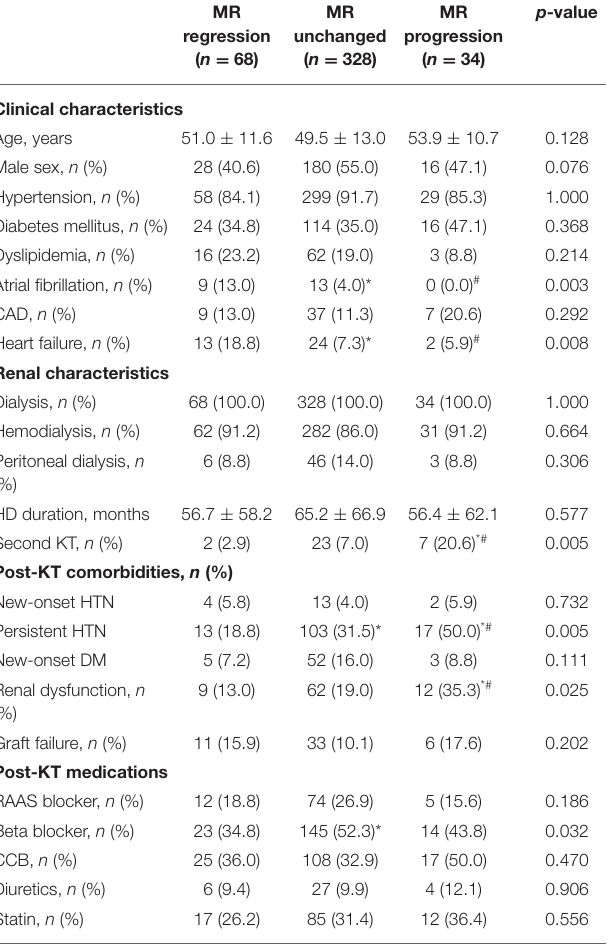
TABLE 2 | Comparison of echocardiographic characteristics in the three groups according to change in mitral regurgitation. MR